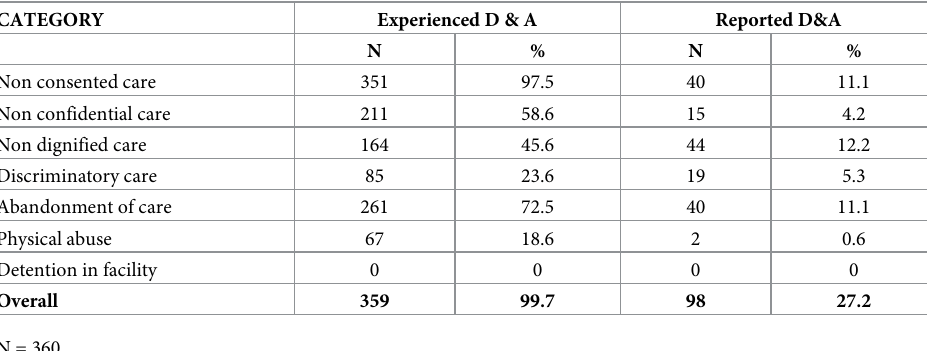
Table 4. Experienced and reported D & A.